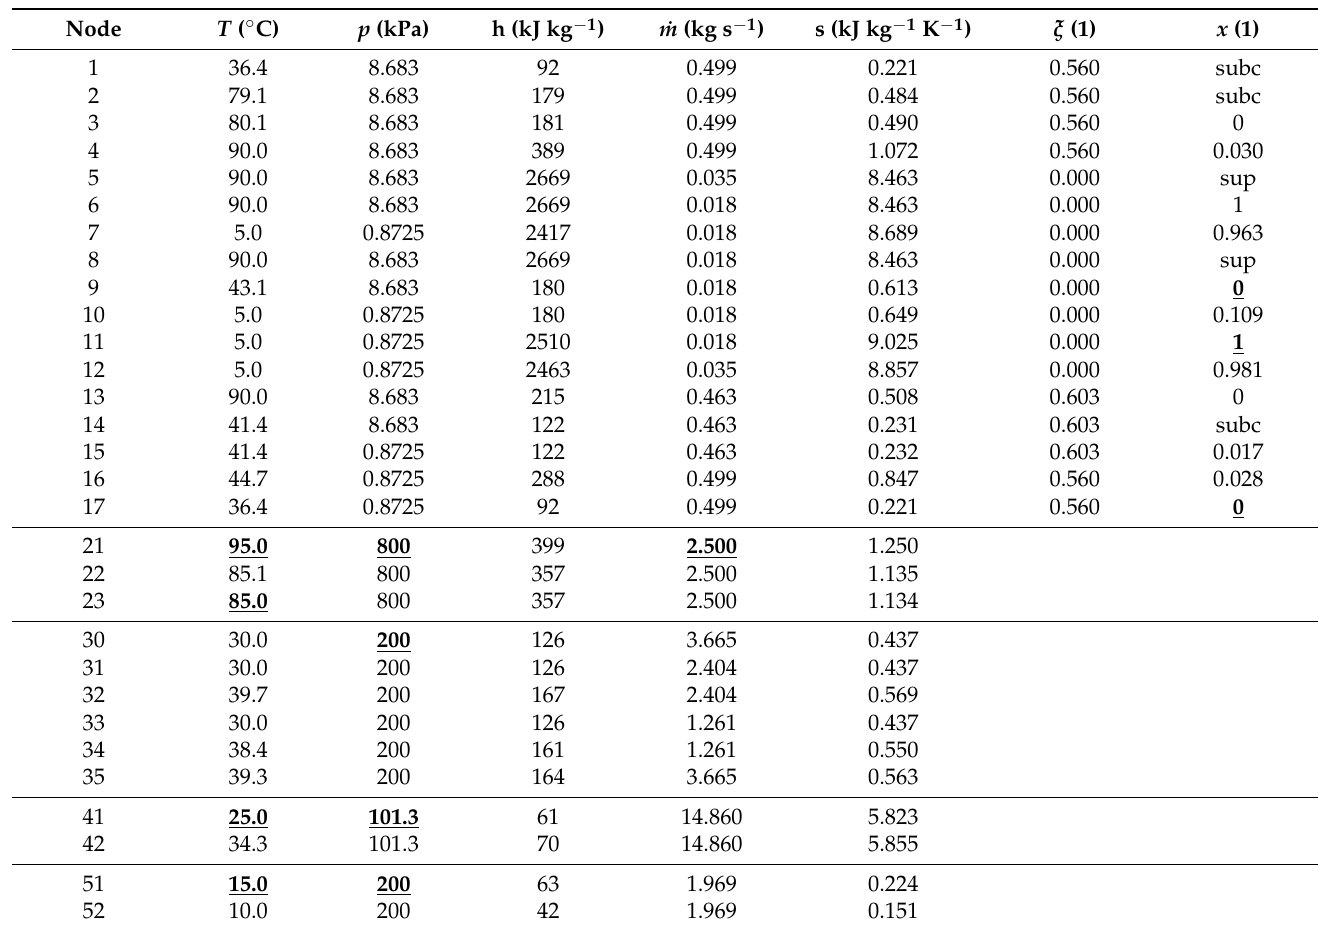
Table A1. Parameters of the APCC in its nodes for baseline conditions (imposed values in underscored bold).